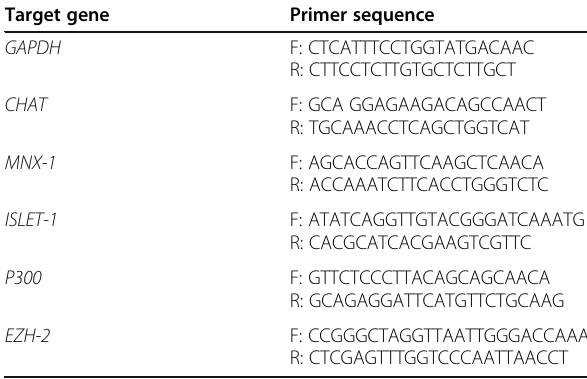
Table 1 List of primers used in qRT-PCR